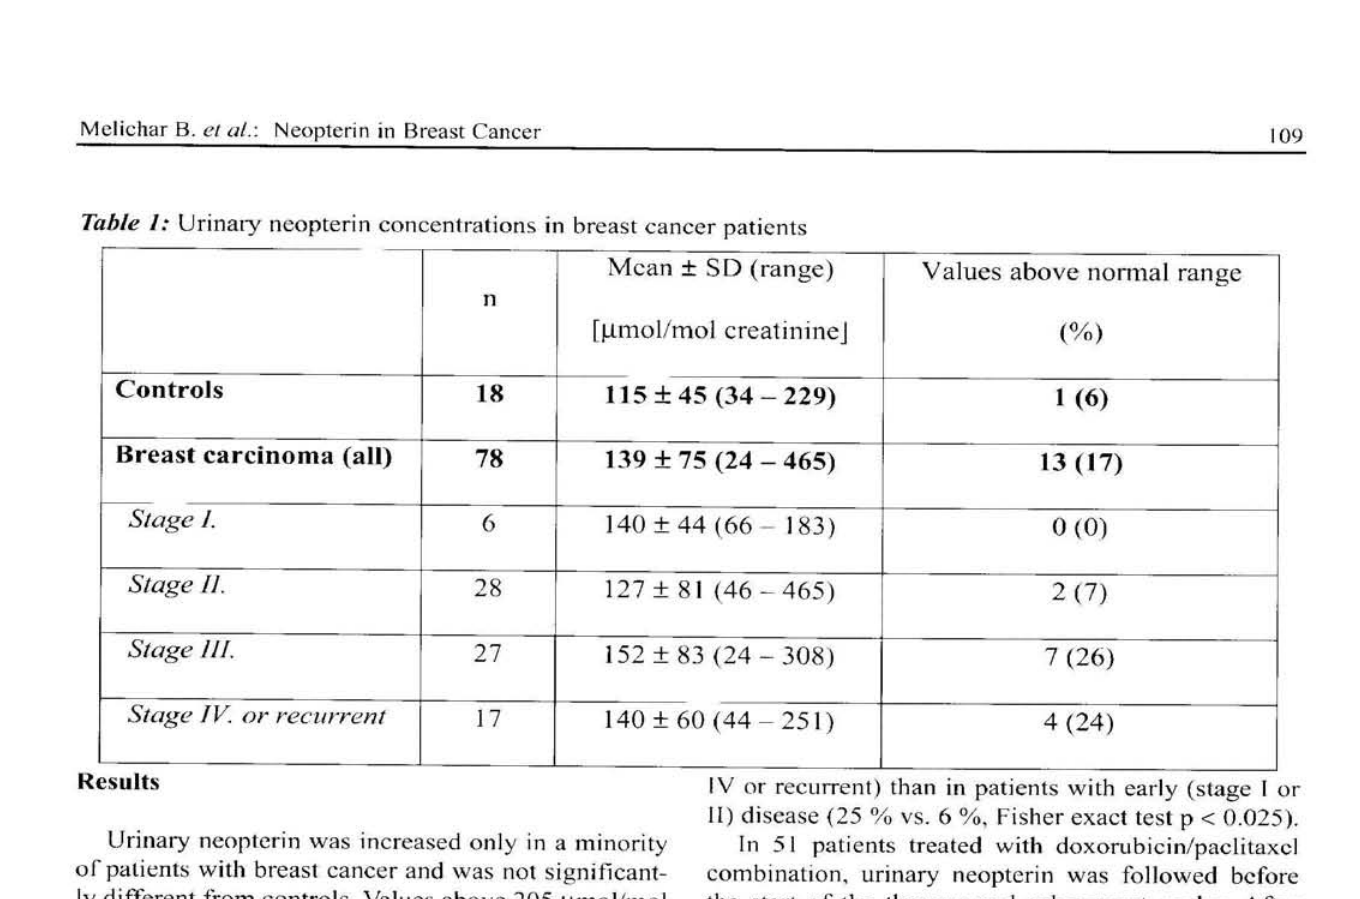
Values above normal range